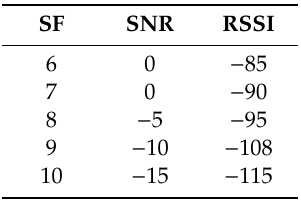
Table 3. The thresholds of the signal-to-noise ratio (SNR) and RSSI for each SF.